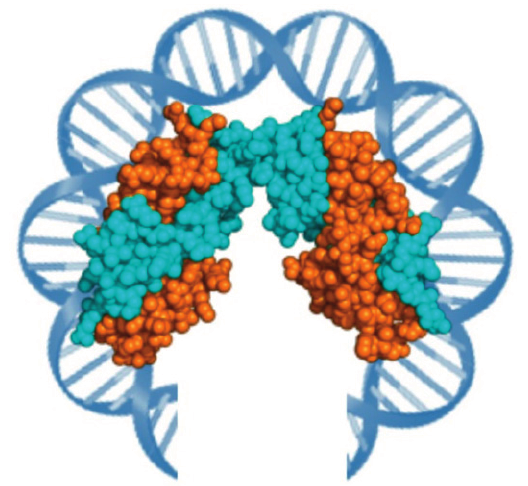
Figure 1. Structure of the M. fervidus histone tetramer in complex with DNA (PDB ID: 1B67), with the HmfA (orange) and HMfB (cyano)